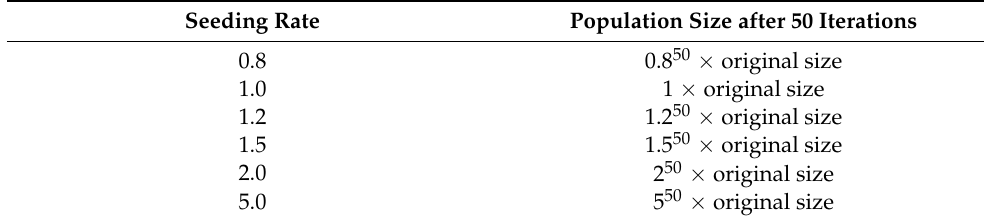
Table 2. Seeding rate and population